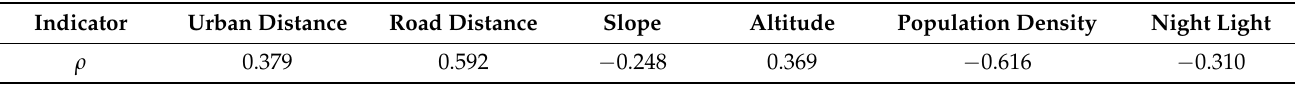
Table 5. Correlation between evaluation indicators and score in the third-layer grid.